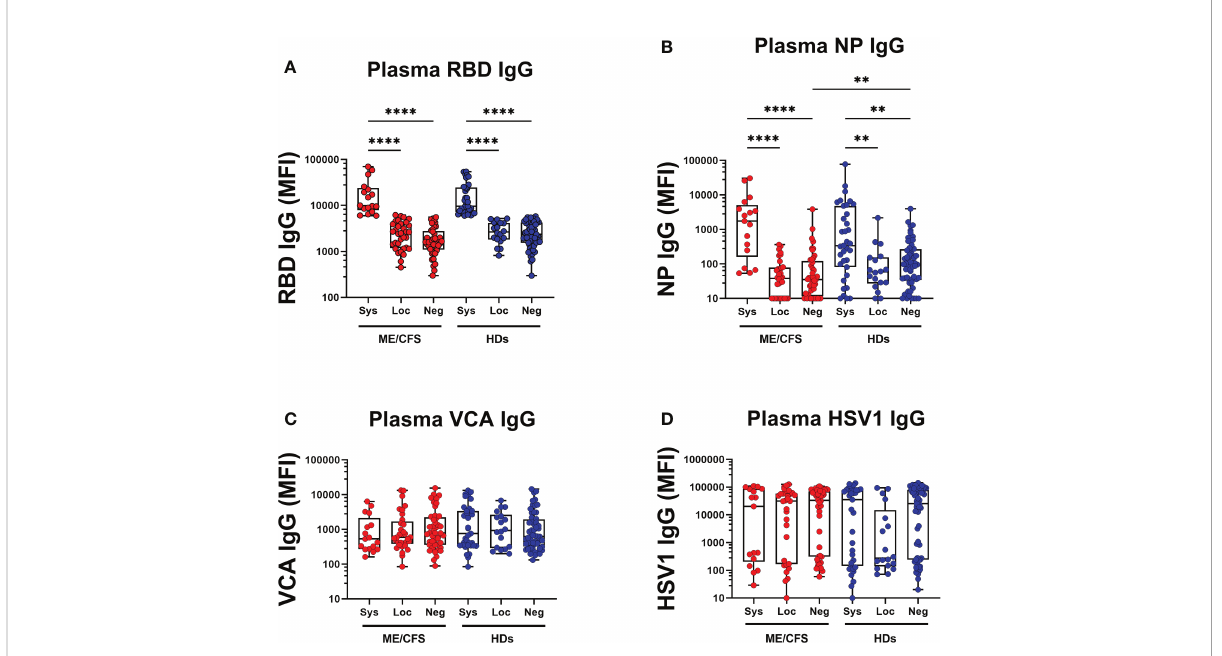
FIGURE 8 SARS-CoV-2 infection generates a distinct antibody fi ngerprint of latent virus reactivation in saliva but not in plasma. (A) SARS-CoV-2-RBD (RBD), (B) SARS-CoV-2 NP (NP), (C) Epstein-Barr viral capsid antigen (VCA), and (D) herpes simplex virus-1 (HSV1) in patients with ME/CFS (ME) and healthy donors (HDs). Sys, participants RBD-positive for systemic response in plasma. Loc, participants RBD-positive for local response in saliva. Neg, participants RBD-negative both in plasma and saliva. Data are presented as boxplots with median values with 25 th and 75 th percentile. MFI, median fl uorescence index. Statistically signi fi cant differences according to non-parametric Kruskal-Wallis procedure and false discovery rate adjustment (5%), are indicated as ** p < 0.01 , and **** p < 0.0001